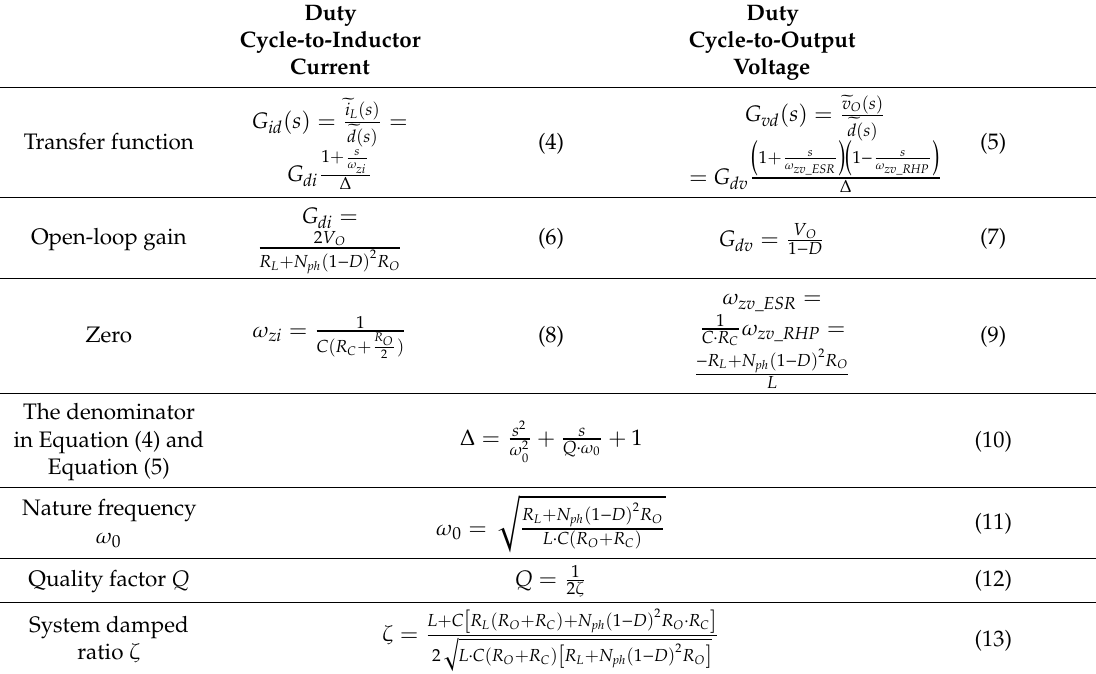
Table 2. Transfer functions of duty cycle-to-inductor current G id ( s ) and duty cycle-to-output voltage G vd ( s ) , where C is output capacitance, R C is capacitor internal resistance, L is boost inductance, R L is inductor internal resistance, N ph is a number of phases, D is nominal duty ratio, and R O is the load